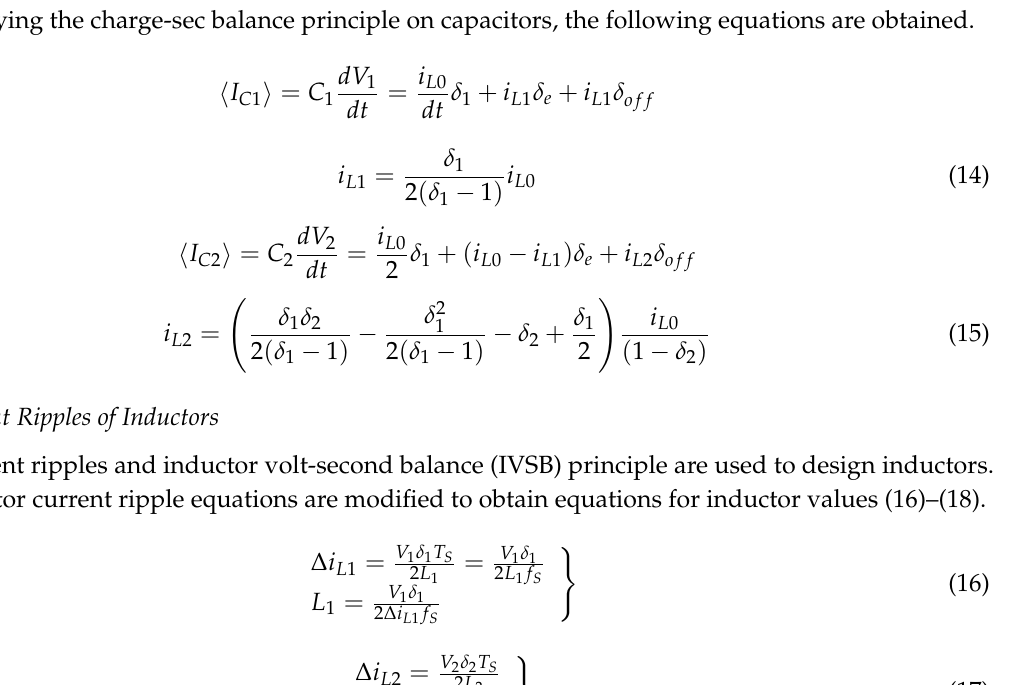
Figure 8. Voltage gain Vs Duty cycle of NI-TPC converter.